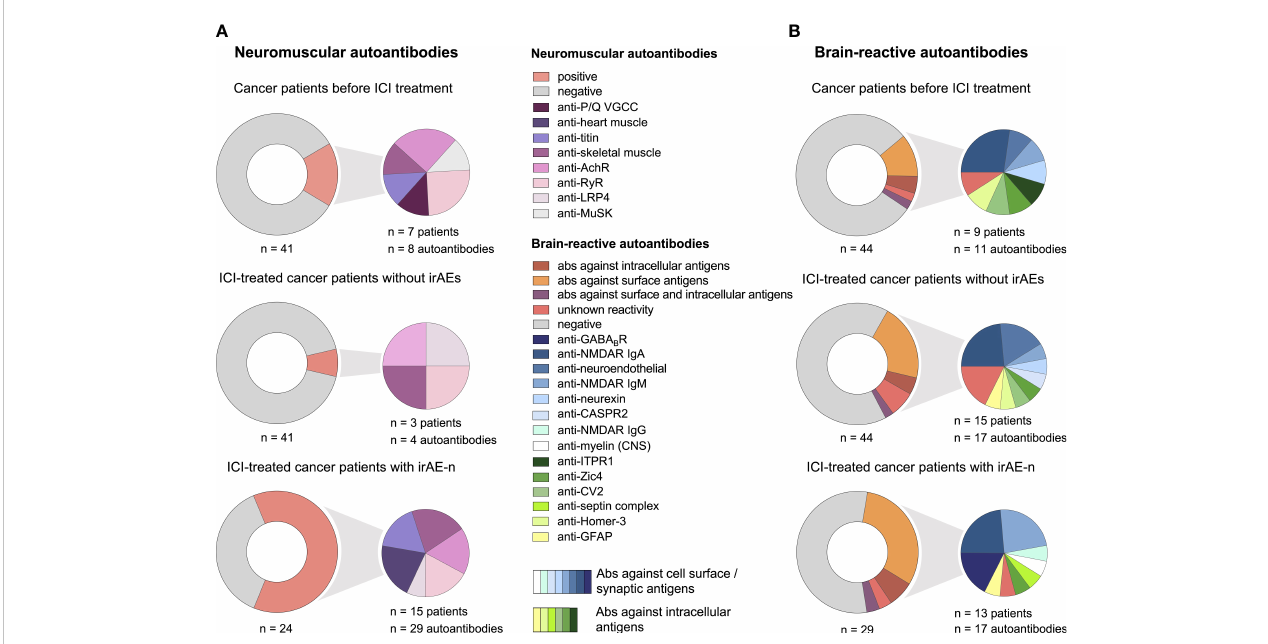
FIGURE 2 Serum autoantibody pro fi les in cancer patients with irAE-n and controls. (A) Frequency and speci fi cation of neuromuscular autoantibodies of 41 cancer patients before ( upper left) and six weeks after ( middle left ) ICI treatment initiation who did not develop high-grade (= CTCAE ≥ 3) irAEs and 24 ICI- treated cancer patients with irAE-n ( lower left ). (B) Frequency and speci fi cation of brain-reactive autoantibodies of 44 cancer patients before ( upper right) and six weeks after ( middle right ) ICI treatment initiation who did not develop high-grade (CTCAE ≥ 3) irAEs and 29 ICI-treated cancer patients with irAE-n ( lower right) . Ab, autoantibody; AchR, acetylcholine receptor; CASPR2, contactin-associated protein-like 2; GABA B R, gamma-aminobutyric-acid B receptor; GFAP, glial fi brillary acidic protein; Homer-3, Homer protein homolog 3; ICI, immune checkpoint inhibitor; irAEs, immune related adverse events; irAE-n, neurological immune related adverse event; ITPR1, inositol 1,4,5-trisphosphate receptor 1; LRP4, low-density lipoprotein receptor-related protein 4; MuSK, muscle-speci fi c tyrosine kinase; NMDAR, N-methyl-D-aspartate receptor; P/Q VGCC, P/Q-type voltage gated calcium channel; RyR, ryanodine receptor; Zic4, zinc fi nger